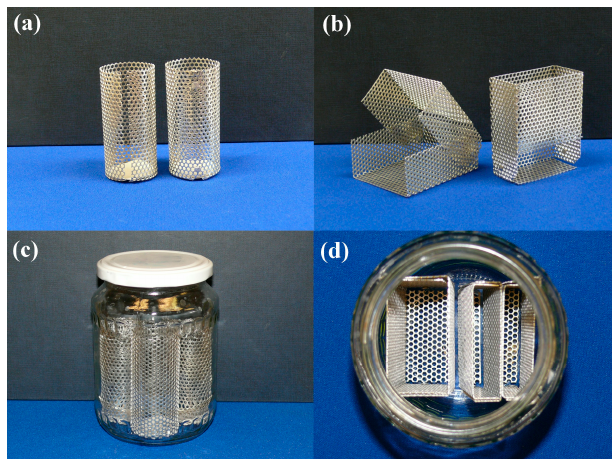
Figure 2. Cylindrical and rectangular frames for holding, aging, solvent exchanging and drying of wet gels, made of punched aluminum plates. All frames are customized, ( a ) and ( b ) free-standing frames, ( c ) and ( d ) frames placed in a fruit jar to show space filling.